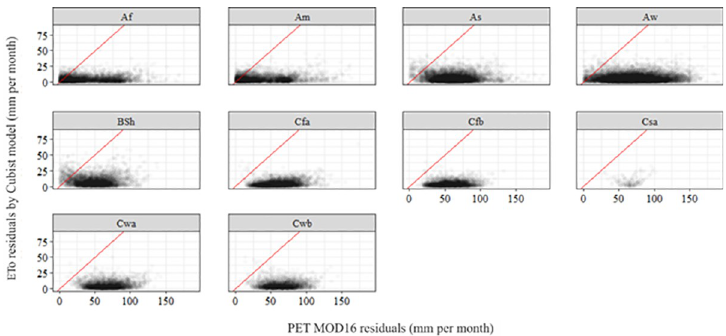
PLOS ONE | https://doi.org/10.1371/journal.pone.0245834 February 9,